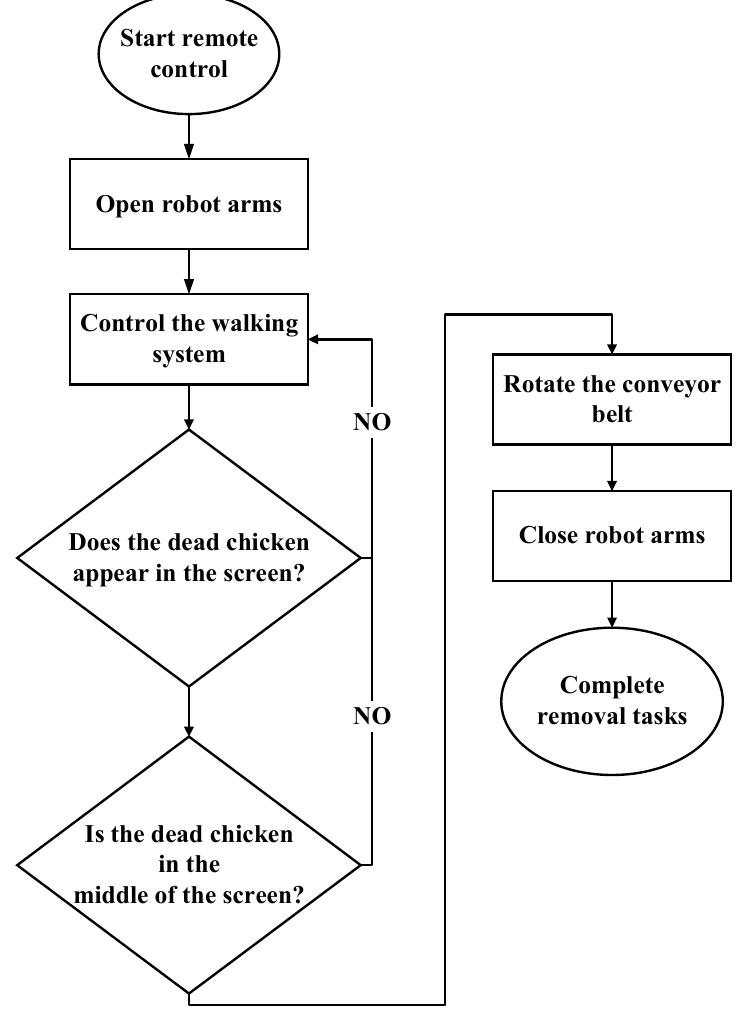
Figure 8. The remote control procedure for the developed system.